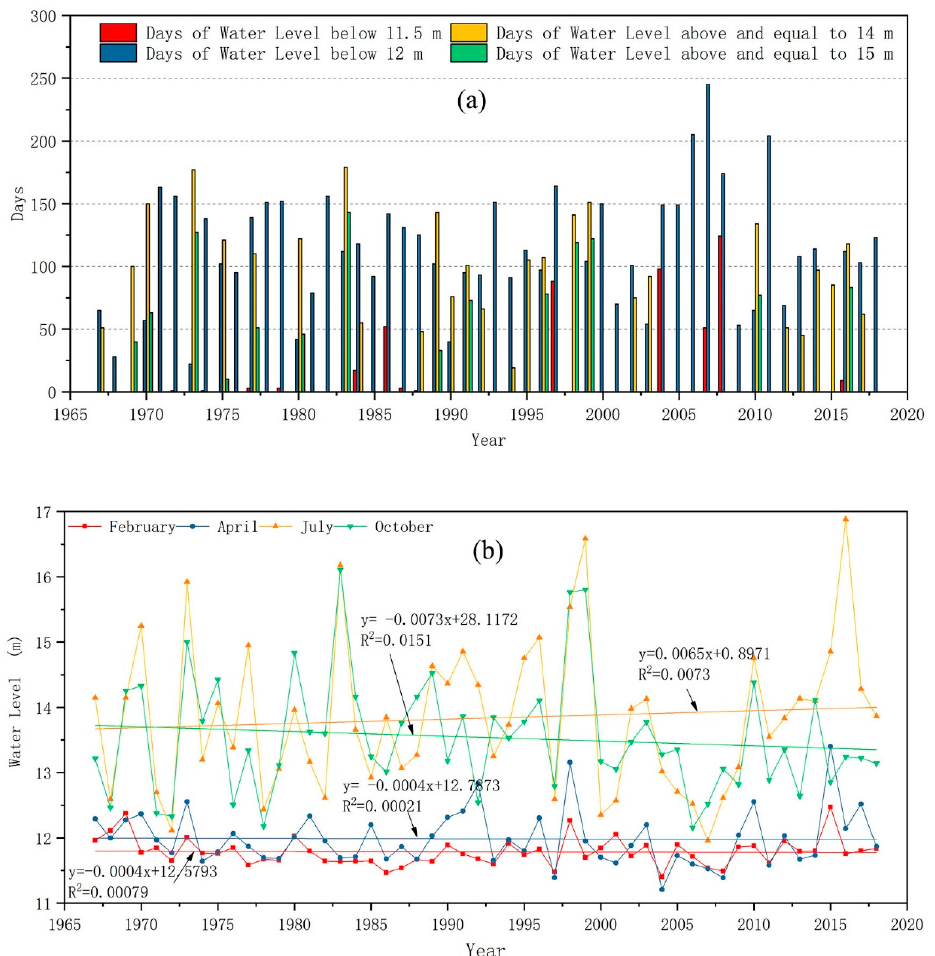
Figure 4. ( a ) Days of extreme low water level ( < 11.5 m or < 12 m) and extreme high water level ( ≥ 14 m or ≥ 15 m) from 1967 to 2018; and ( b ) Long term variations of water level in February, April, July and October in Huayang